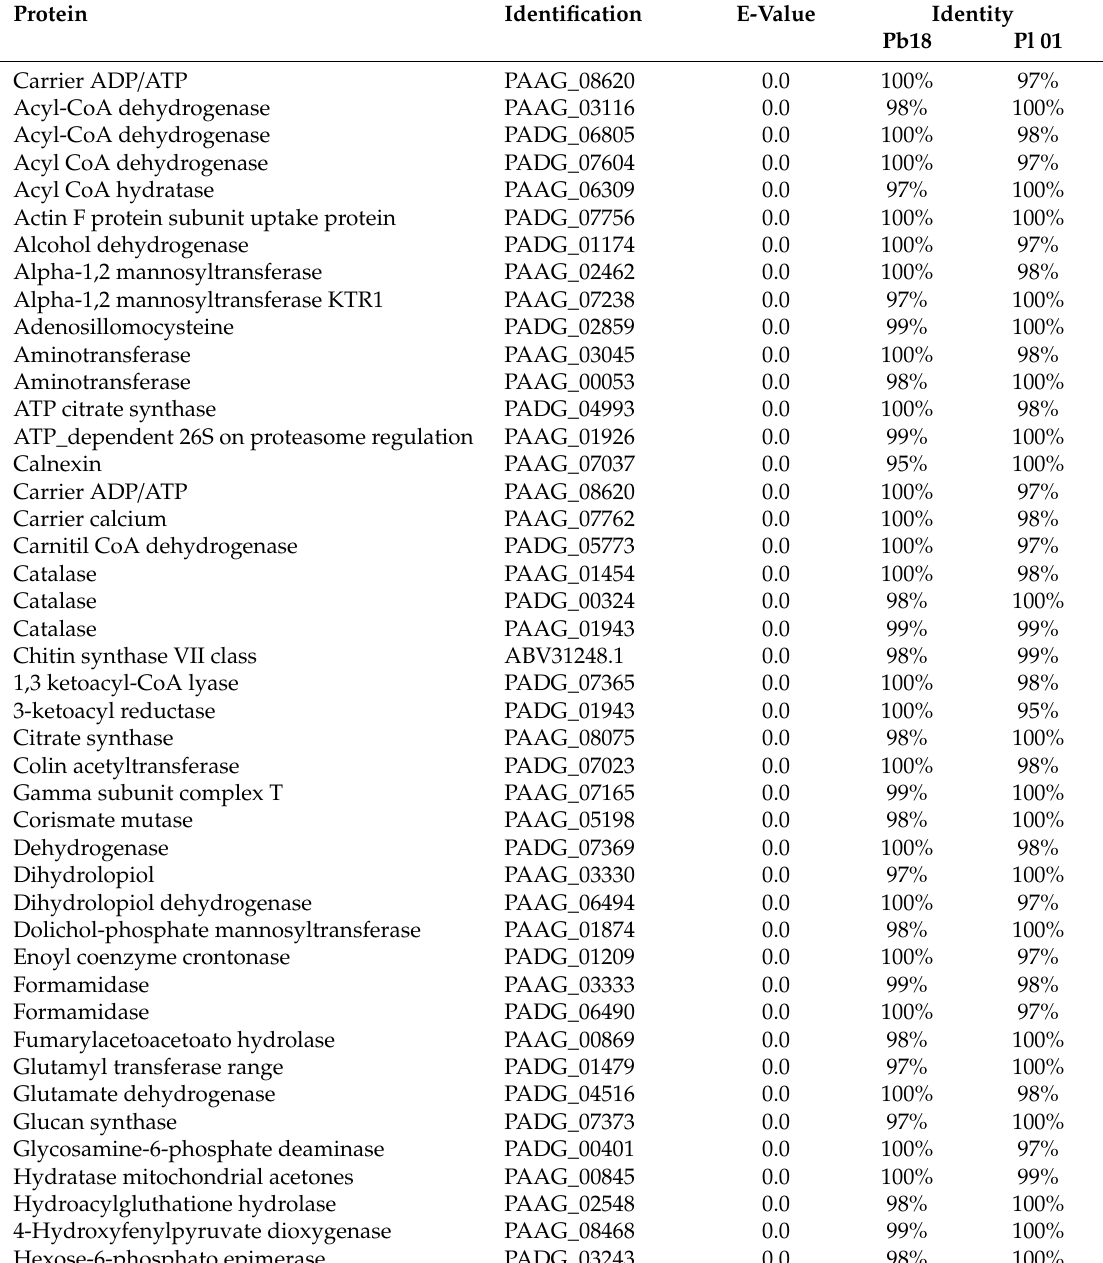
Table 2. Alignment of amino acid sequences of P. brasiliensis and P. lutzii by the BLAST